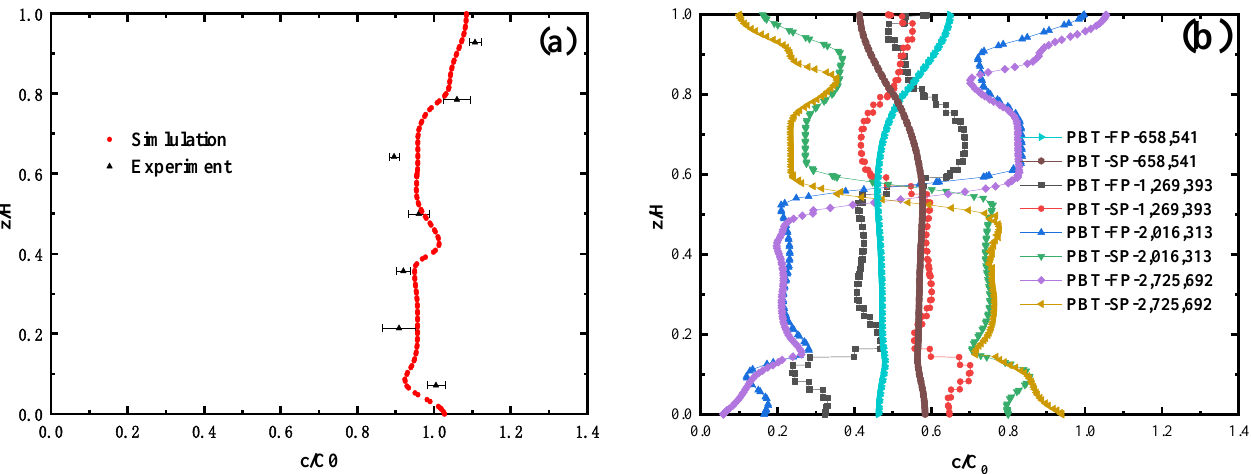
Figure 2. Model validation and mesh independence: ( a ) axial 60 mm solid holdup curve; ( b ) mesh independence.